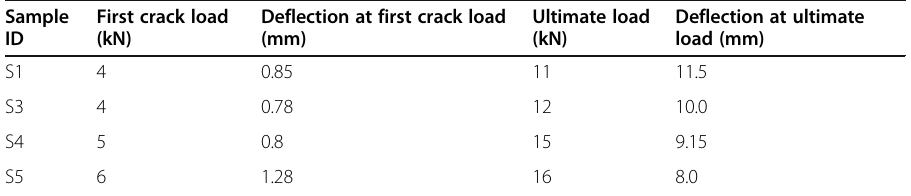
Table 6 Deflection at first crack load and ultimate load of samples